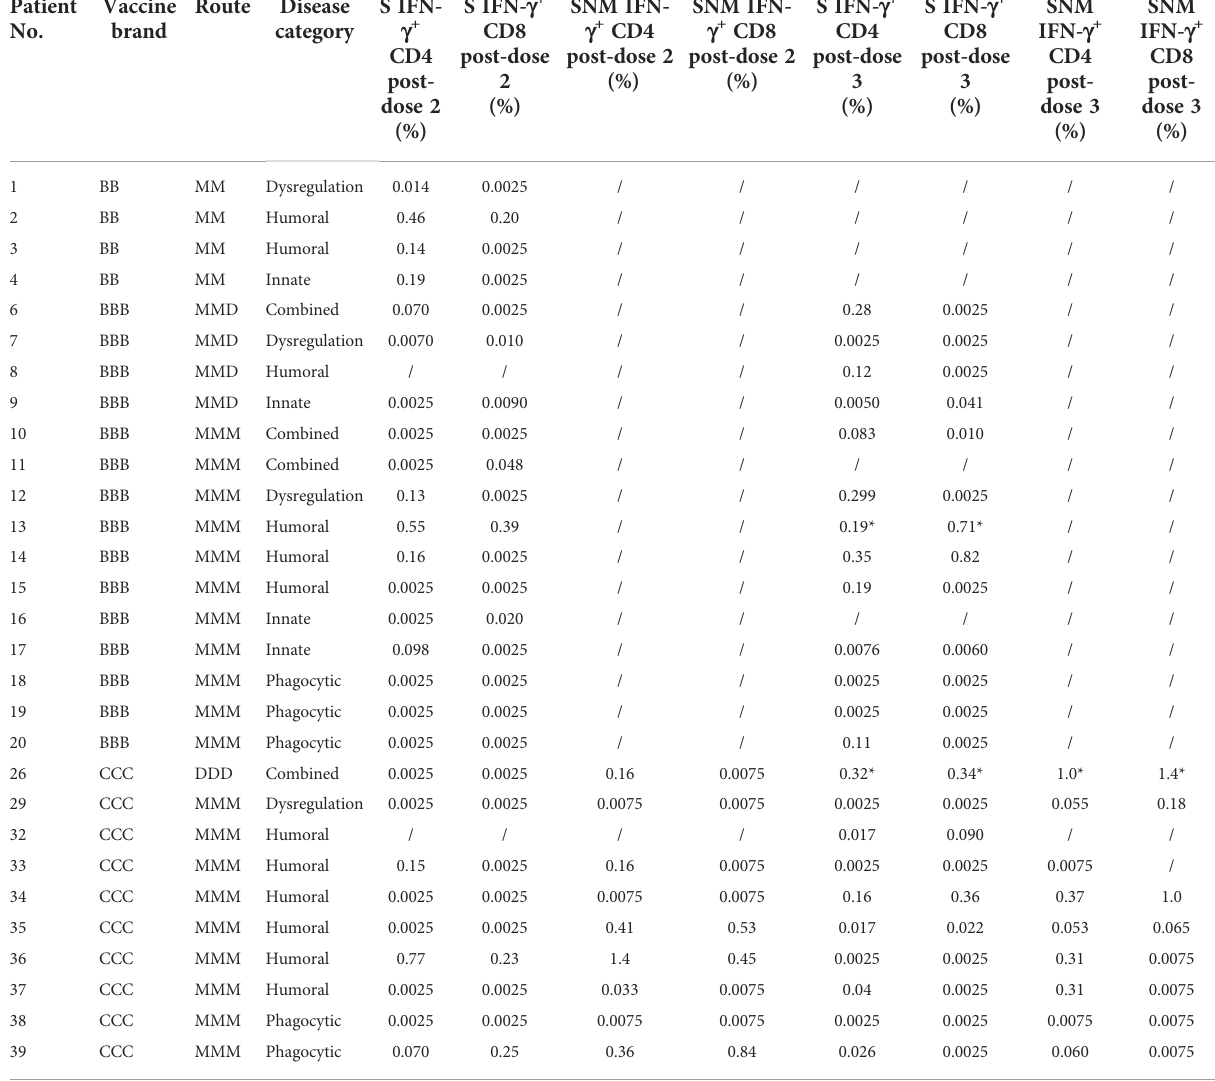
TABLE 3 S-speci fi c and SNM-speci fi c IFN- g + CD4 and CD8 T cell responses in IEI patients. Patient